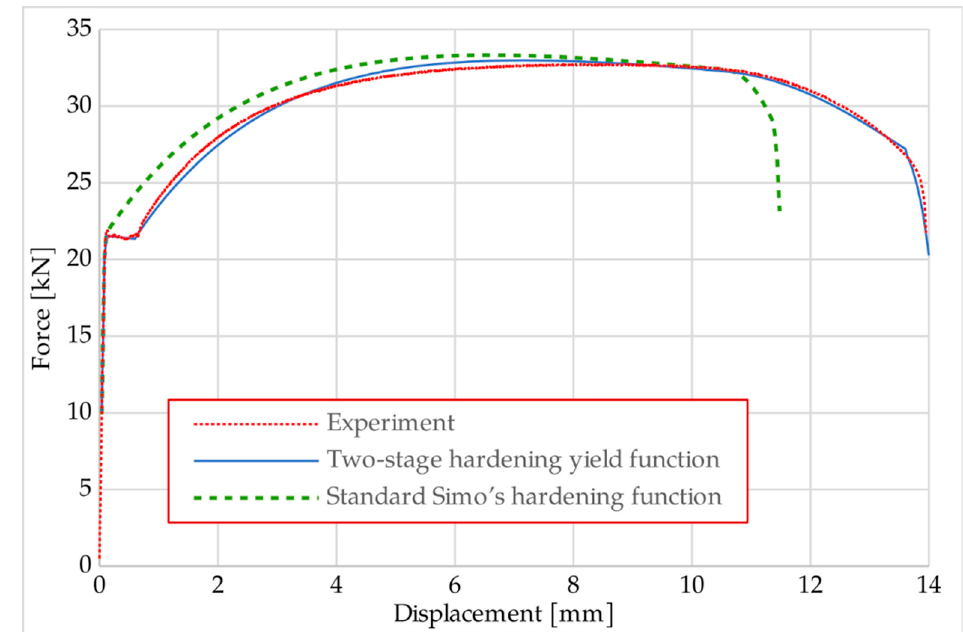
Figure 18. Comparison of the standard and the proposed two-stage hardening function for the same material parameters given in Table 1.